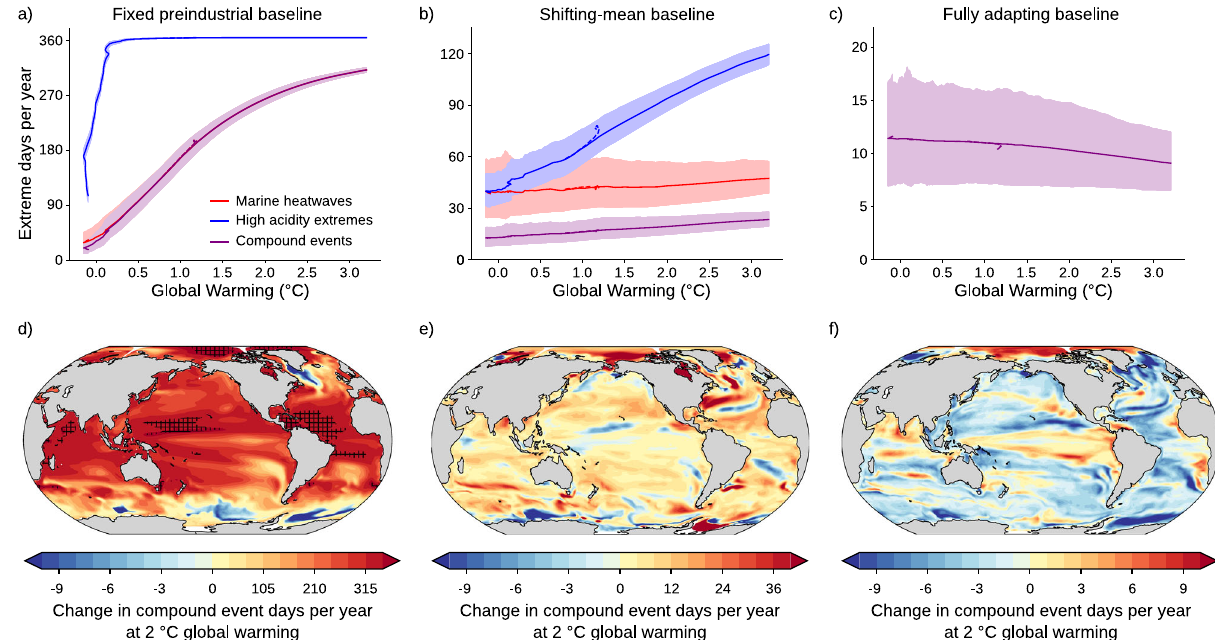
Fig. 4 | Projected changes in the number of MHW-OAX event days per year under global warming. a – c Global-mean number of yearly extreme-event days relativetoglobalwarminglevelswithrespecttopreindustrialconditionsforMHWs (redlines),OAXevents(bluelines),andcompoundMHW-OAXevents(purplelines) for a fi xed preindustrial baselines, b shifting-mean baselines, and c fully adapting baselines. The time series are smoothed with a 21-year running mean fi lter. Thick lines display the ensemble means and shaded areas depict the 10th and 90th per- centile ranges of the 30 ensemble member simulations over the 1861 – 2100 period following the RCP8.5 scenario during the period 2006 – 2100. The dashed lines in a – c show ensemble-mean changes relative to warming levels under the